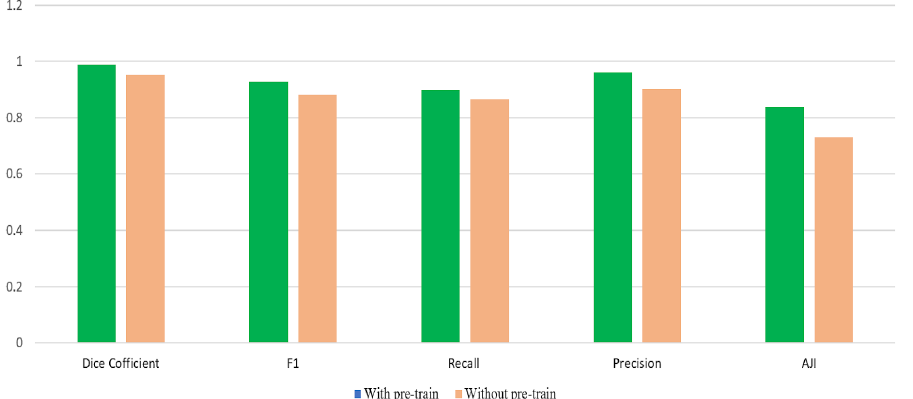
Figure 13. The performance comparison of the CBA model with and without the pre-trained model in the DSB